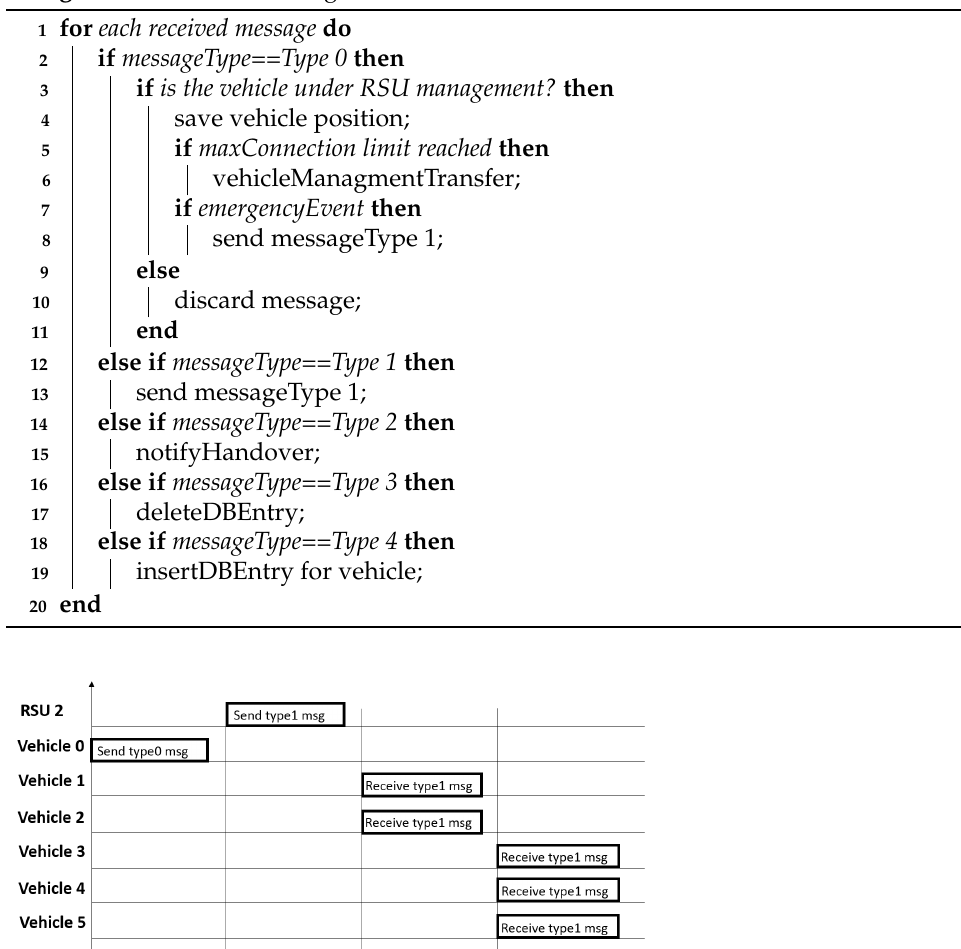
Algorithm 2: Cell breathing-like Control Mechanism.